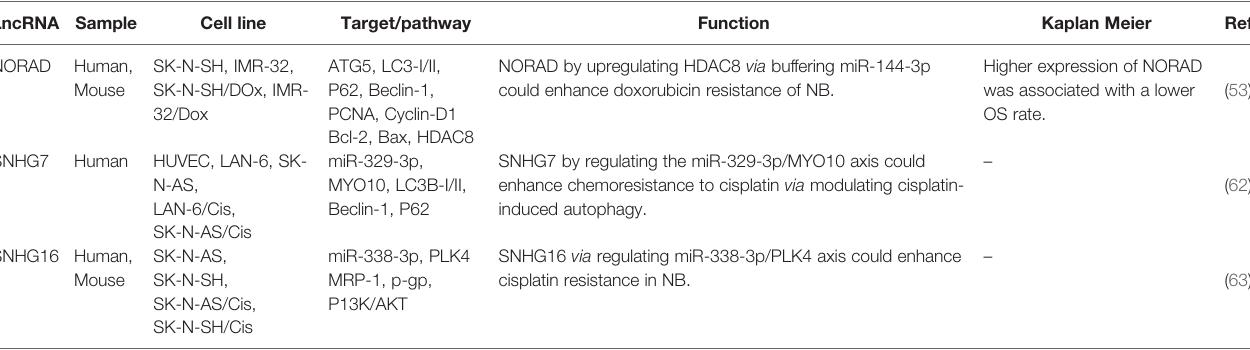
TABLE 2 | LncRNAs that modulate the response of neuroblastoma to